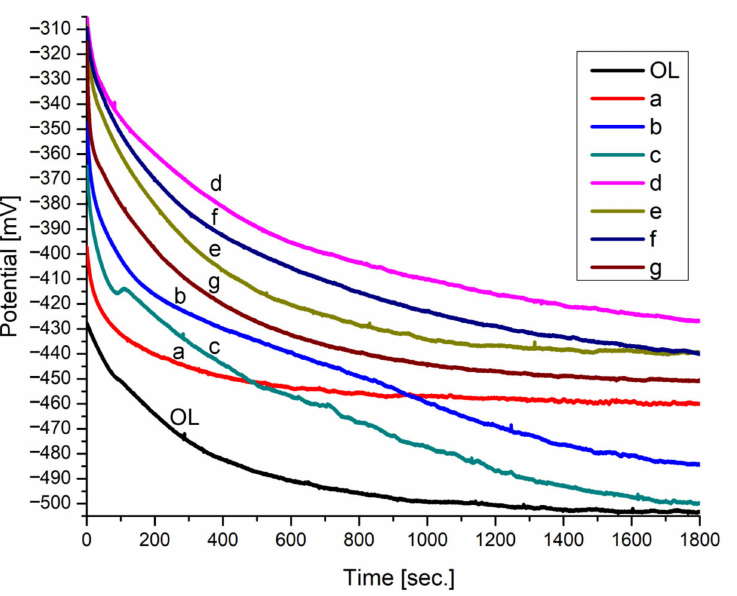
Figure 4. The OCP of the thin film electrodes immersed in 0.1 M HCl: OL bare W1.4043: (a) MnTa 2 O 6 (h); (b) 5-(4-carboxy-phenyl)-10,15,20-tris (4-methyl-phenyl)-porphyrin; (c) 5-(4-methyl- benzoate)-10,15,20-tris (4-methyl-phenyl)-porphyrin; (d) 5-(4-carboxy-phenyl)-10,15,20-tris (4-methyl- phenyl)–porphyrin/MnTa 2 O 6 (h); (e) MnTa 2 O 6 (h)/5-(4-carboxy-phenyl)-10,15,20-tris (4-methyl- phenyl)-porphyrin; (f) 5-(4-methyl-benzoate)-10,15,20-tris (4-methyl-phenyl)-porphyrin/MnTa 2 O 6 (h); (g) MnTa 2 O 6 (h)/5-(4-methyl-benzoate)-10,15,20-tris